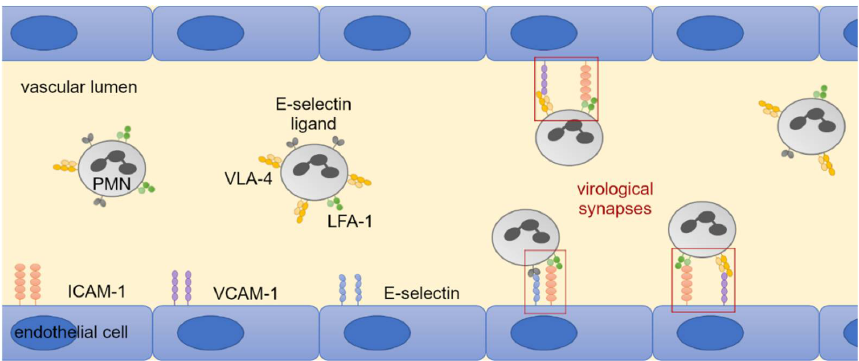
that both subunits of LFA-1 are required for an efficient transfer of cell-associated HCMV from infected PMNs to endothelial cells.